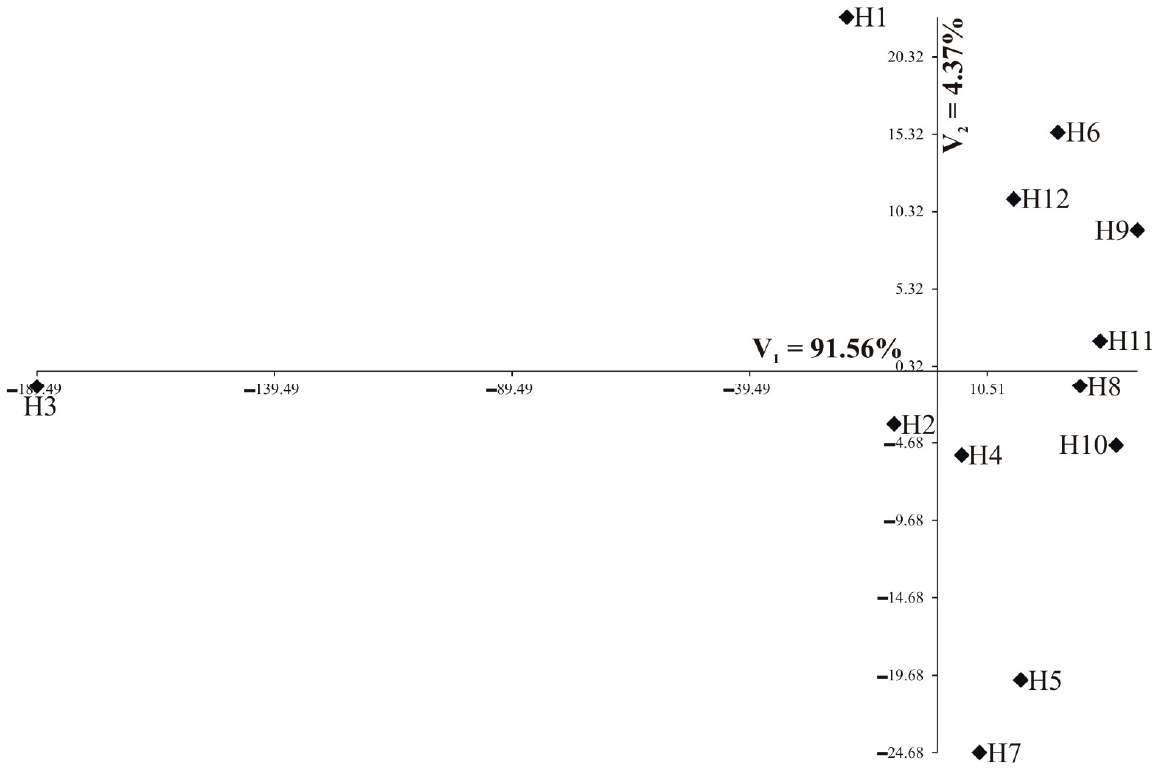
Figure 5. Distribution of 12 hybrids in the space of the first two canonical variables in the vegetative stage (N = 90).